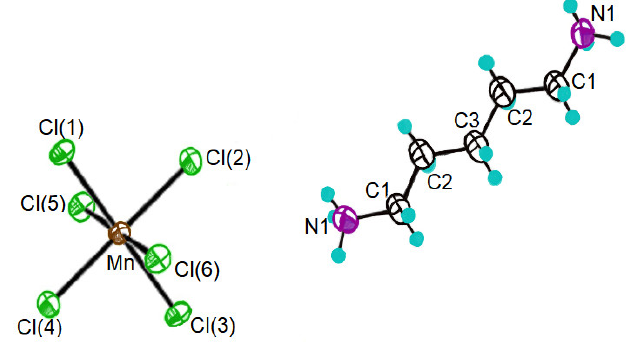
Figure 4. Thermal ellipsoid plot (50% probability) for structure of [NH 3 (CH 2 ) 5 NH 3 ]MnCl 4 at 300 K.